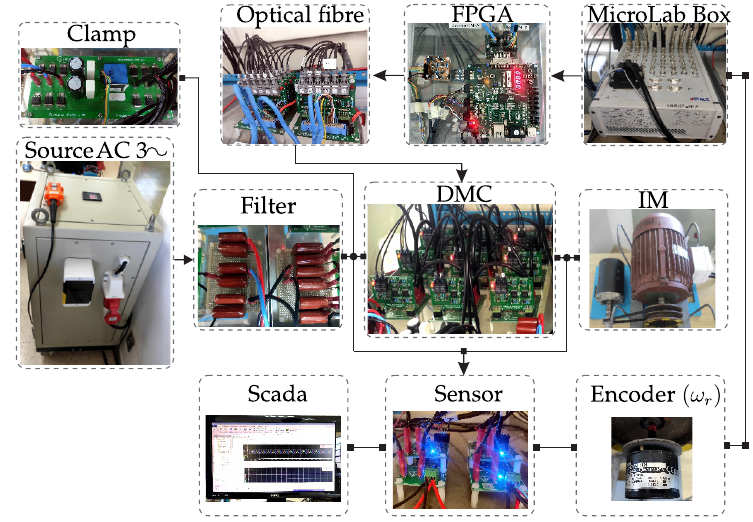
Figure 10. Experimental test bench.